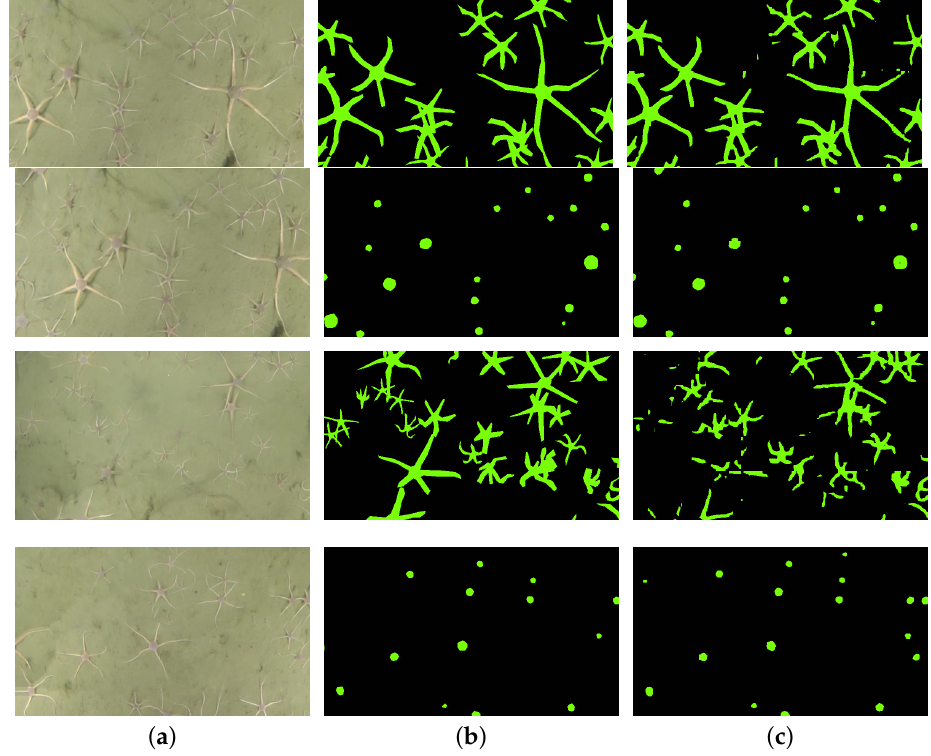
Figure 6. Segmentation results when testing on mosaic-1: comparison between acceptable ( first two rows ) and not so successful ( last two rows ) mask predictions. ( a ) Raw image. ( b ) Ground truth. ( c ) Prediction from